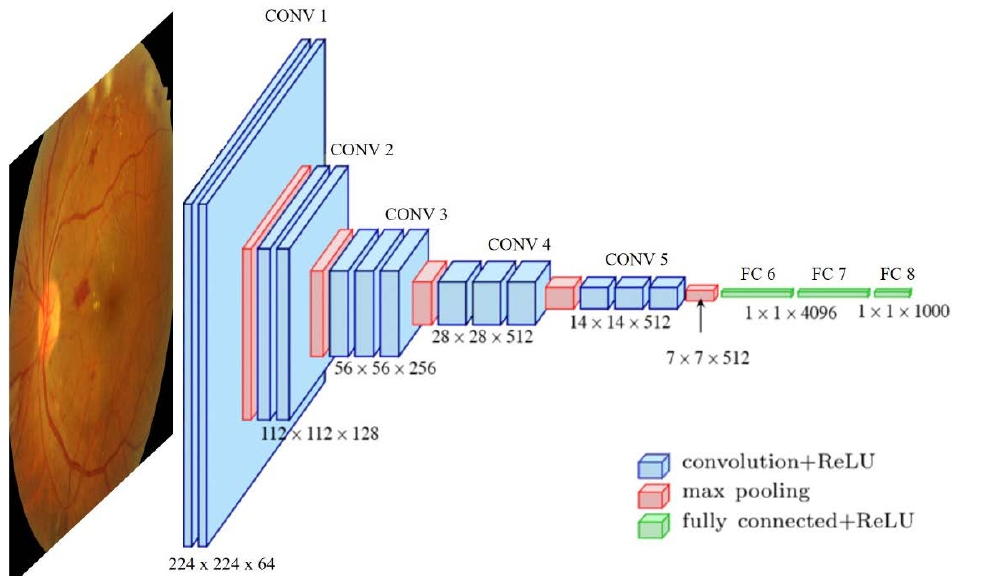
Figure 1. Example of a commonly used convolutional neural network used in medical image analysis. VGG16 architecture proposed by [20] and applied to task classification. Image source